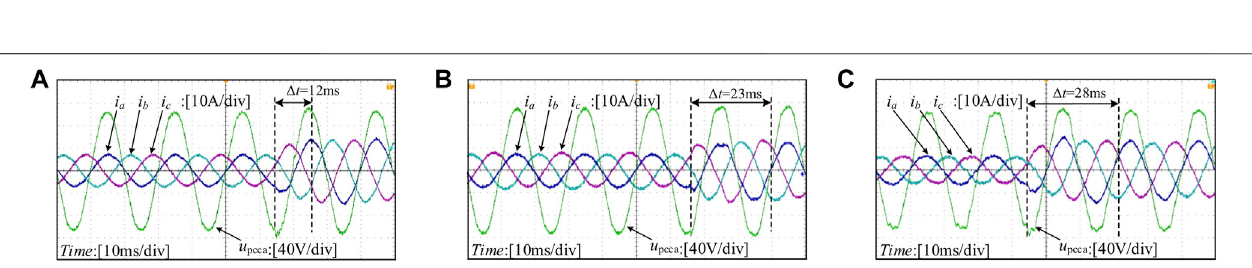
FIGURE11| Dynamicexperimentalresultsoftheinverterat L g (cid:1) 0 mH: (A) )withtheproposedmethodinthispaper, (B) withthemethodinLiuetal.(2020),and (C) with the method in Jiao and Lee (2015).